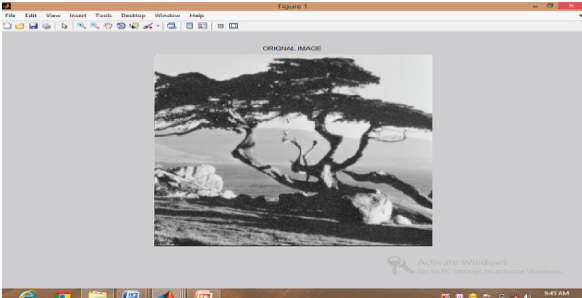
Figure 7: Original image of trees.